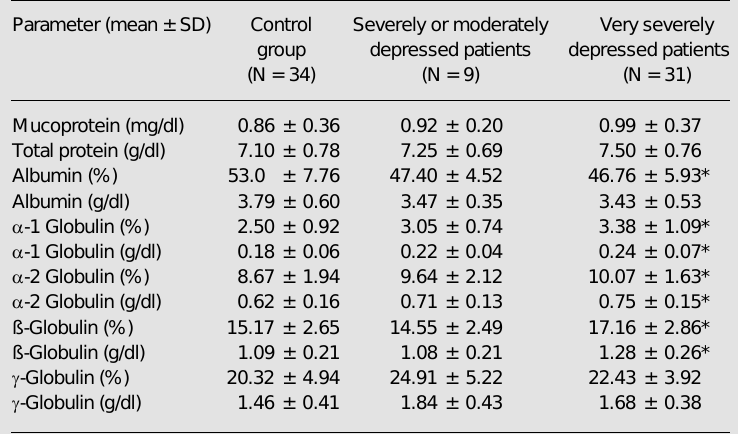
Table 1. Biochemical analysis of the plasma of adults with very severe, severe or moderate depression and control nondepressed subjects. Parameter (mean ±